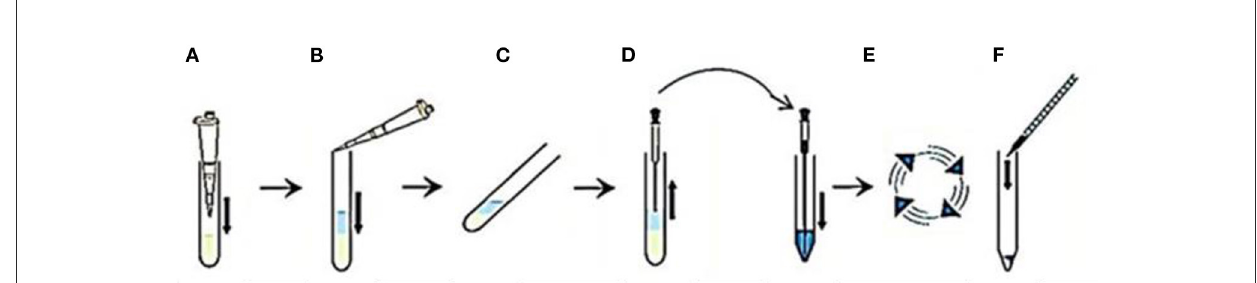
FIGURE1 A flow-diagram describing sperm preparation by swim up method using sp-TALP in the following steps. (A) One milliliter of semen is added into a centrifuge tube. (B) One milliliter of the sp-TALP is added over semen. (C) The tube is incubated in an inclined position for 60min. (D) The upper 0.85mL layer of the motile sperm cells is removed to be placed in a conical tube with adding sp-TALP till reach a final volume of 5mL. (E) Centrifugation for 120g is performed for 10min. (F) The sperm pellet is resuspended in the culture medium.